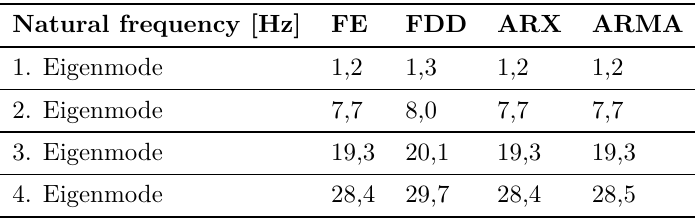
Table 1. Comparison of the natural frequencies of the 4-dof system.